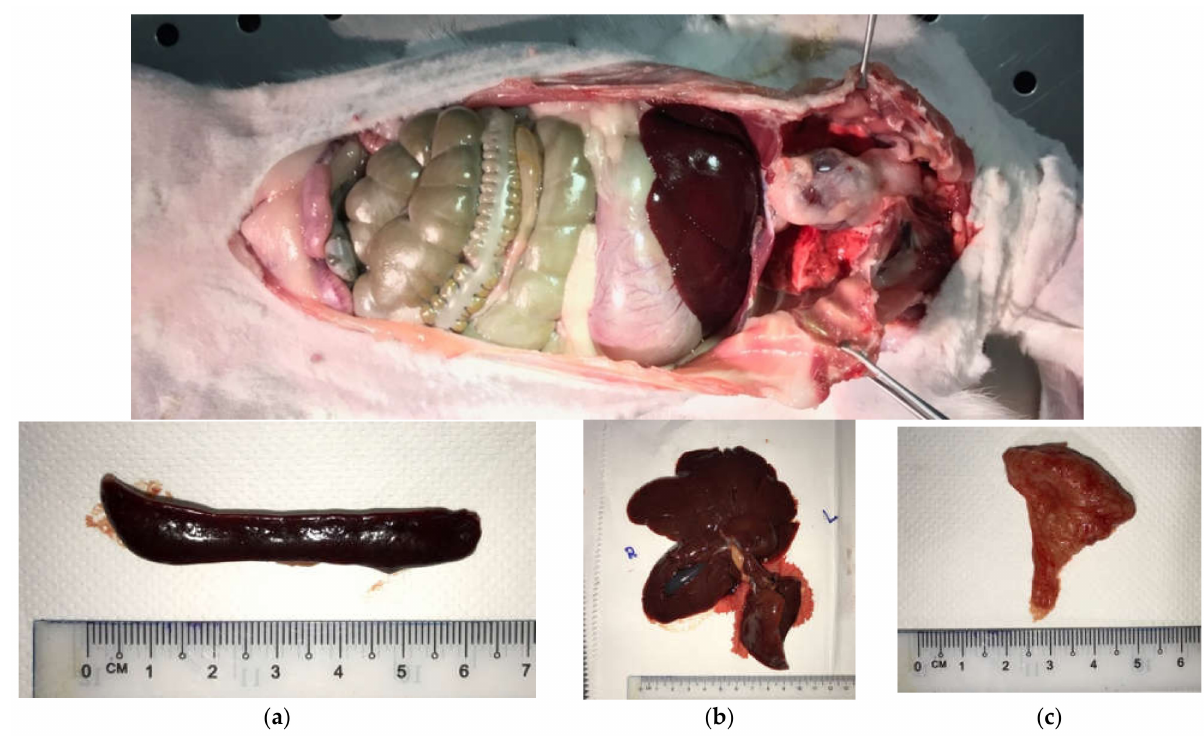
Figure 6. Rabbit abdomen exposed from the neck to the pubic region. The lympho-reticular of rabbit’s organs: ( a ) spleen, ( b ) liver and ( c ) thymus